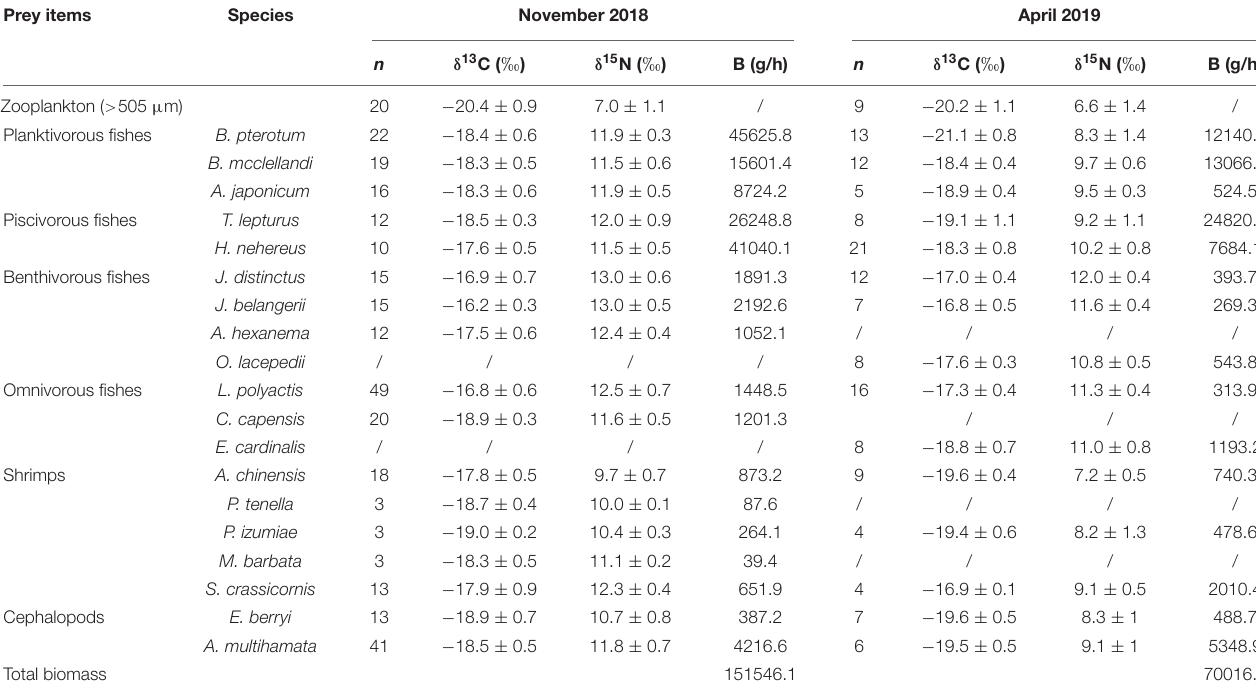
FIGURE 2 | Biplots of δ 13 C and δ 15 N values of Bombay duck and their prey items. Small color dots represent different size classes of Bombay duck and prey items are shown as mean ( ± SD). TABLE 1 | Stable isotope signatures (mean ± SD) and biomass (B) of Bombay duck’s prey; n represents the replicates of samples. Prey items